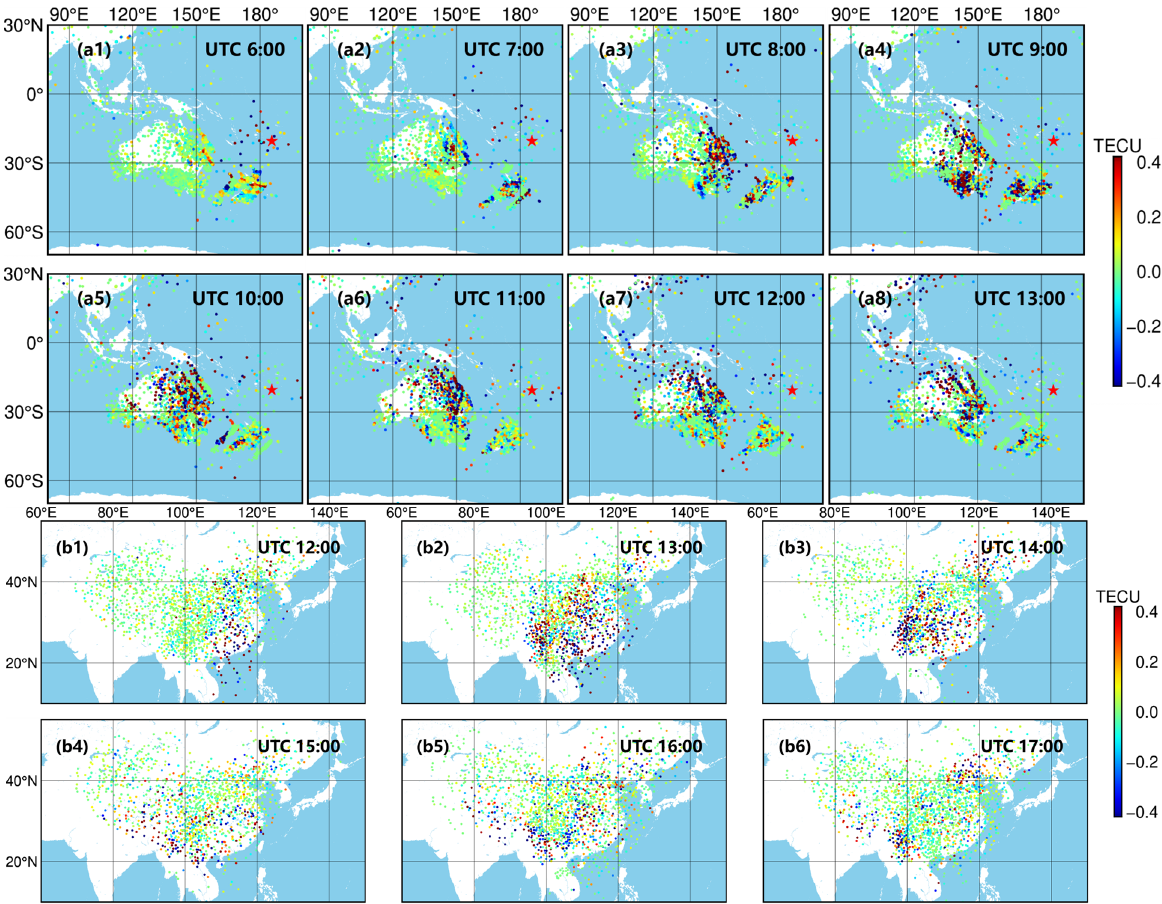
Figure 4 . The propagation of TID in the western Pacific Rim ( a1–a8 ) New Zealand and Australia Figure 4. The propagation of TID in the western Pacific Rim ( a1 – a8 ) New Zealand and Australia ( b1–b6 ) China. ( b1 – b6 )